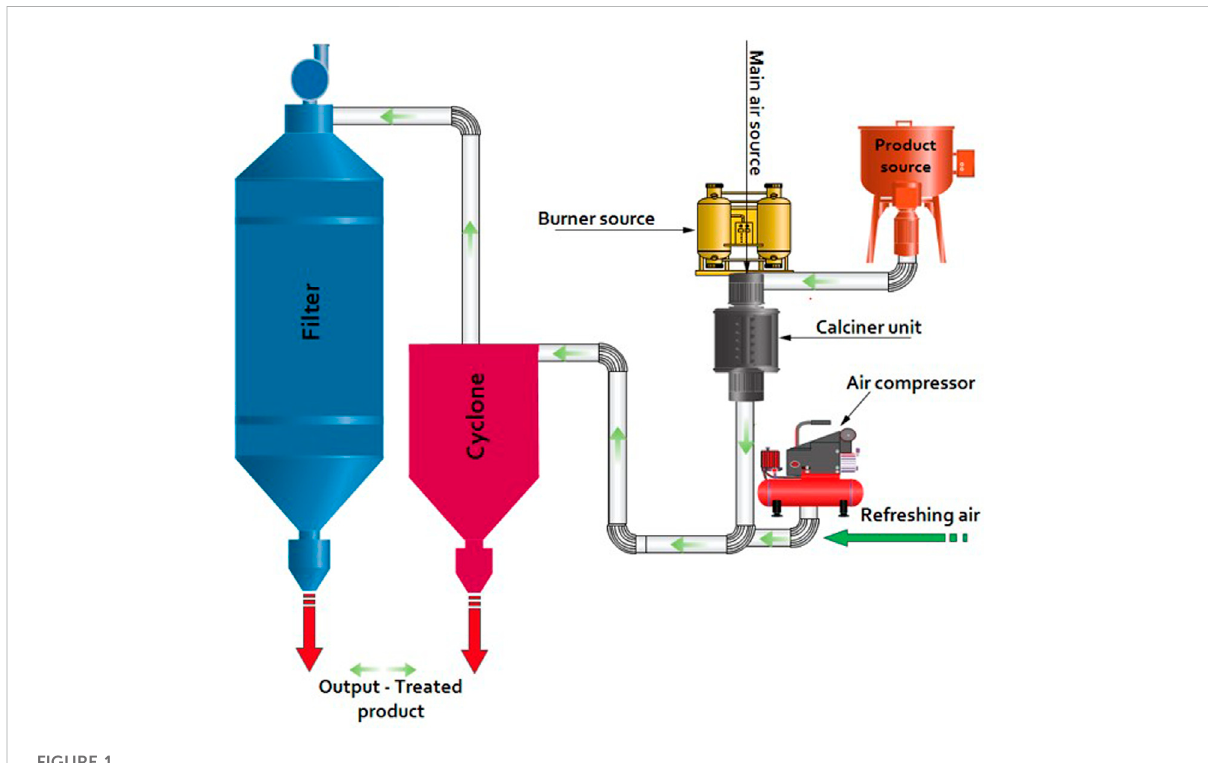
FIGURE 1 Flash calcination process.